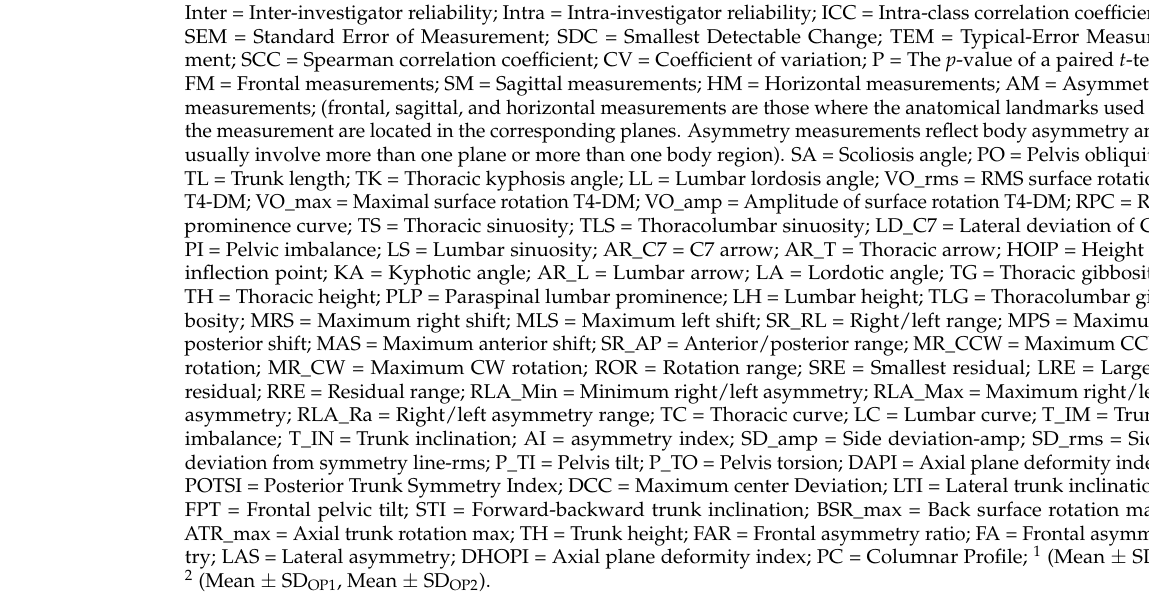
Table 7. Description of ST